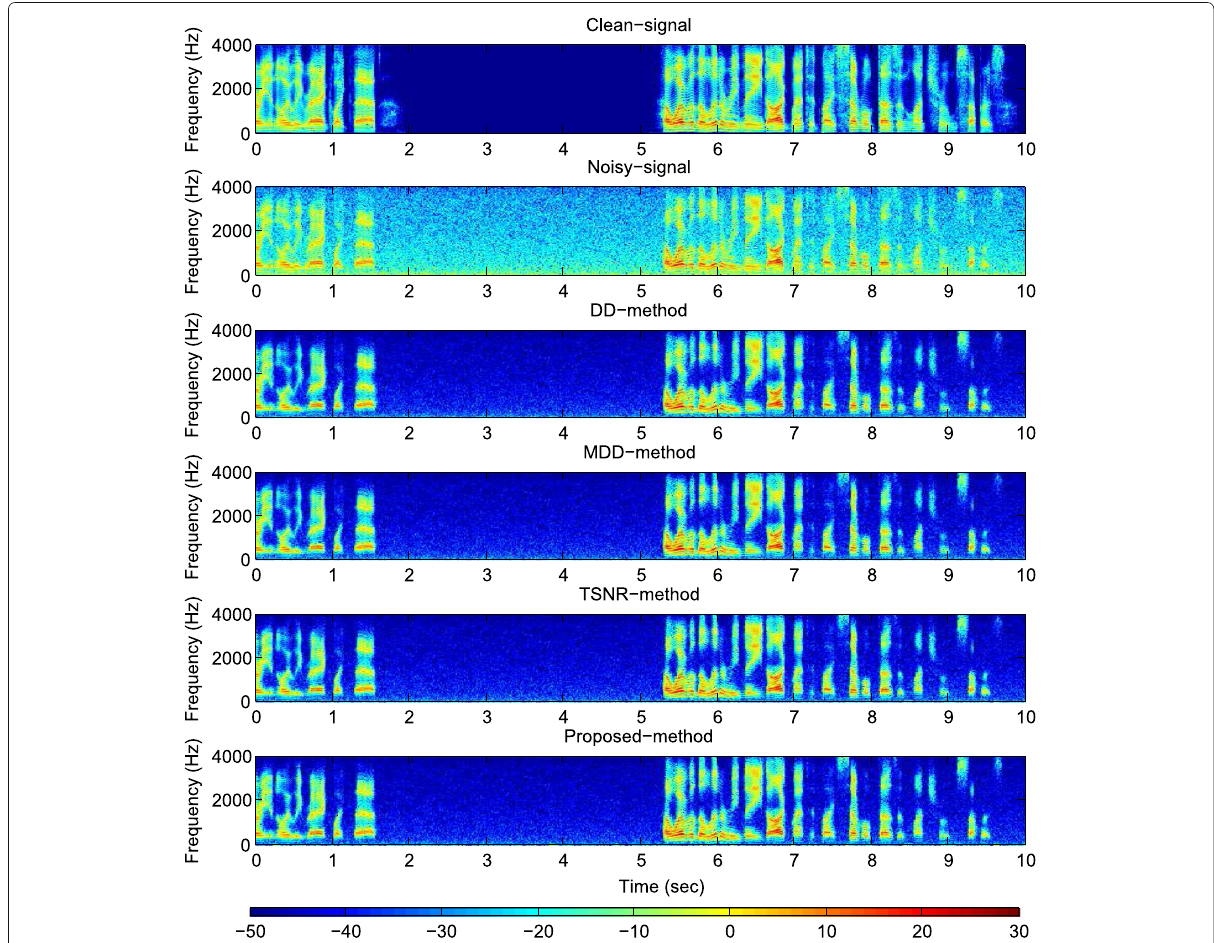
Fig. 7 Speech spectrograms for noisy speech corrupted with pink noise at 10 dB enhanced by Wiener filter speech estimation